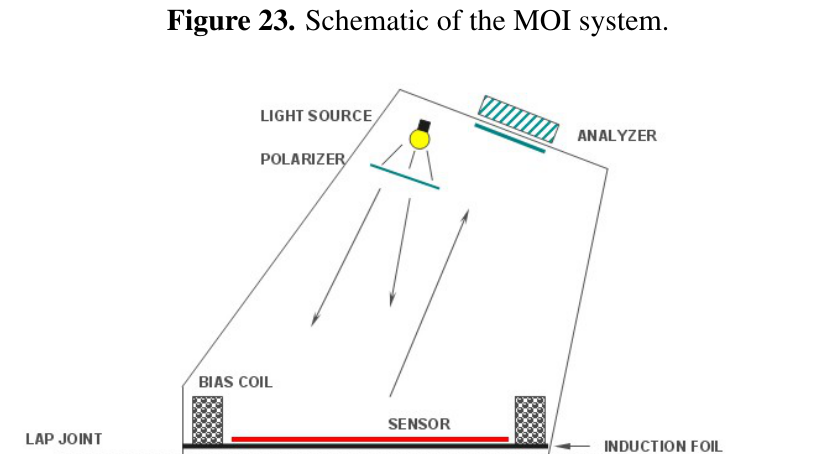
Figure 23. Schematic of the MOI